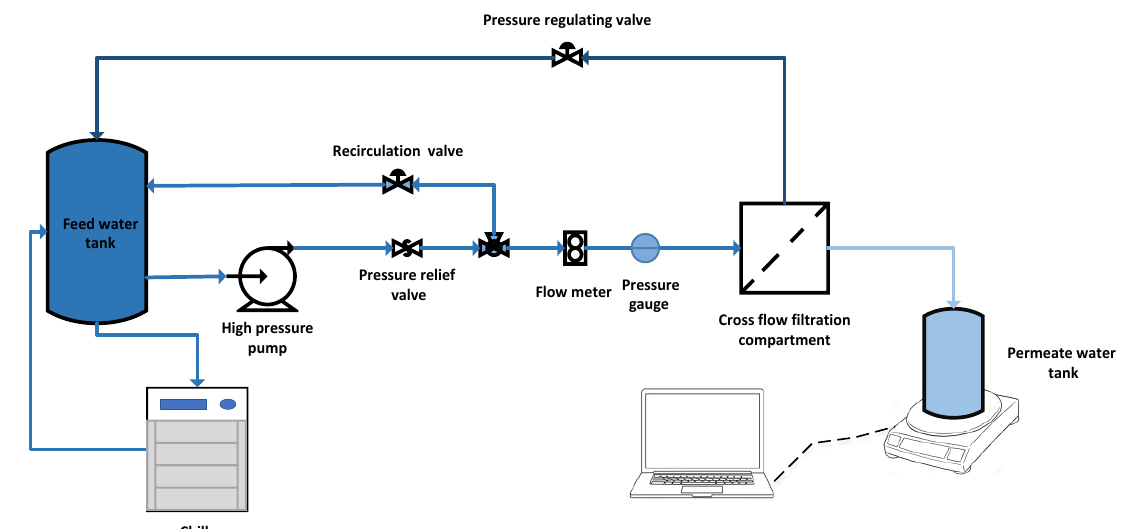
Figure 1. A schematic diagram for the crossflow lab-scale membrane test skid.